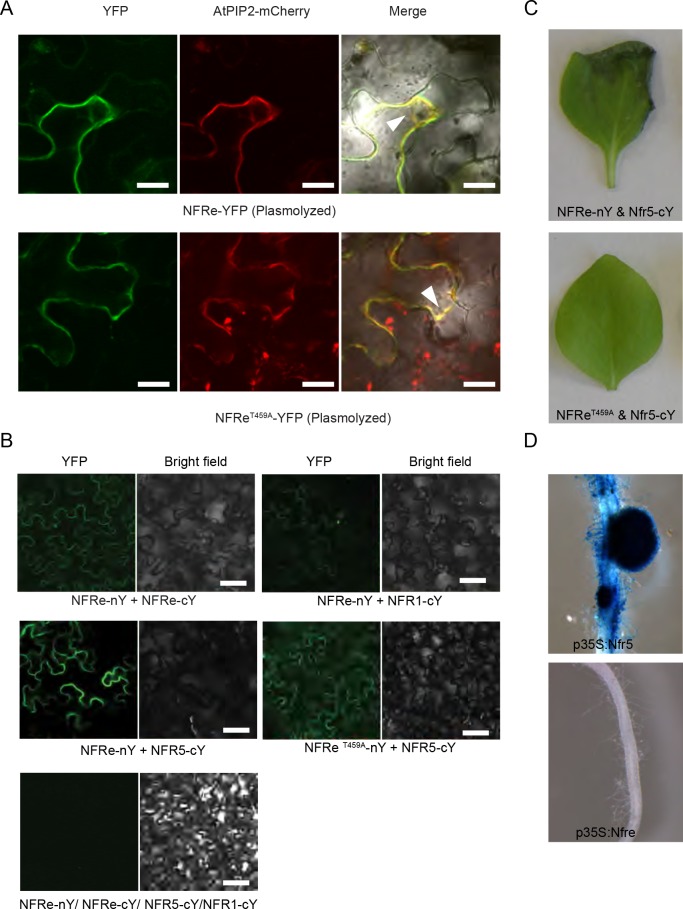
NFRe is localized on plasma membrane and signals together with NFR5.(A) Wild-type and the T459A mutant version of NFRe localize on plasma membrane of N. benthamiana leaf cells. Co-localisation of YFP-labelled NFRe proteins with the AtPIP2-DsRED plasma membrane marker after plasmolysis (arrows) is shown. (B) NFRe forms homo and heteromeric complexes with NFR1 and NFR5 in N. benthemiana leaves. YFP fluorescence is detected when wild type or T459A mutant version of NFRe tagged with the N-terminal part of YFP protein (n–Y) is co-expressed with NFRe, NFR5 or NFR1 tagged with the C-terminal of the YFP (c–Y). No signal is detected when the same constructs are expressed alone. The left panel shows images collected using the YFP channel, and the right panel shows the corresponding bright field image. (C) Co-expression of NFRe and NFR5 induces cell death in N. benthamiana leaves. This phenotype is dependent on the presence of NFR5 and NFRe (upper panel), and on an active NFRe kinase (lower panel). Co-expression of NFRe and NFR1 does not lead to cell death in tobacco leaves (lower panel). A representative image illustrating the absence of cell death is shown in the lower panel for the following expressions: NFReT485A and NFR5, NFRe and NFR1, NFRe, NFR5, NFR1. (D). NFRe signalling in L. japonicus roots is dependent on NFR5. Unlike NFR5 (upper panel), the NFRe, NFR or NeK receptors expressed from the 35S promoter fail to activate Nin promoter in the nfr5-2-Nin:GUS plants exposed to M. loti bacteria for 5 weeks (representative root is shown in the lower panel). Scale bars, 20 μm (A), 100 μm (B).